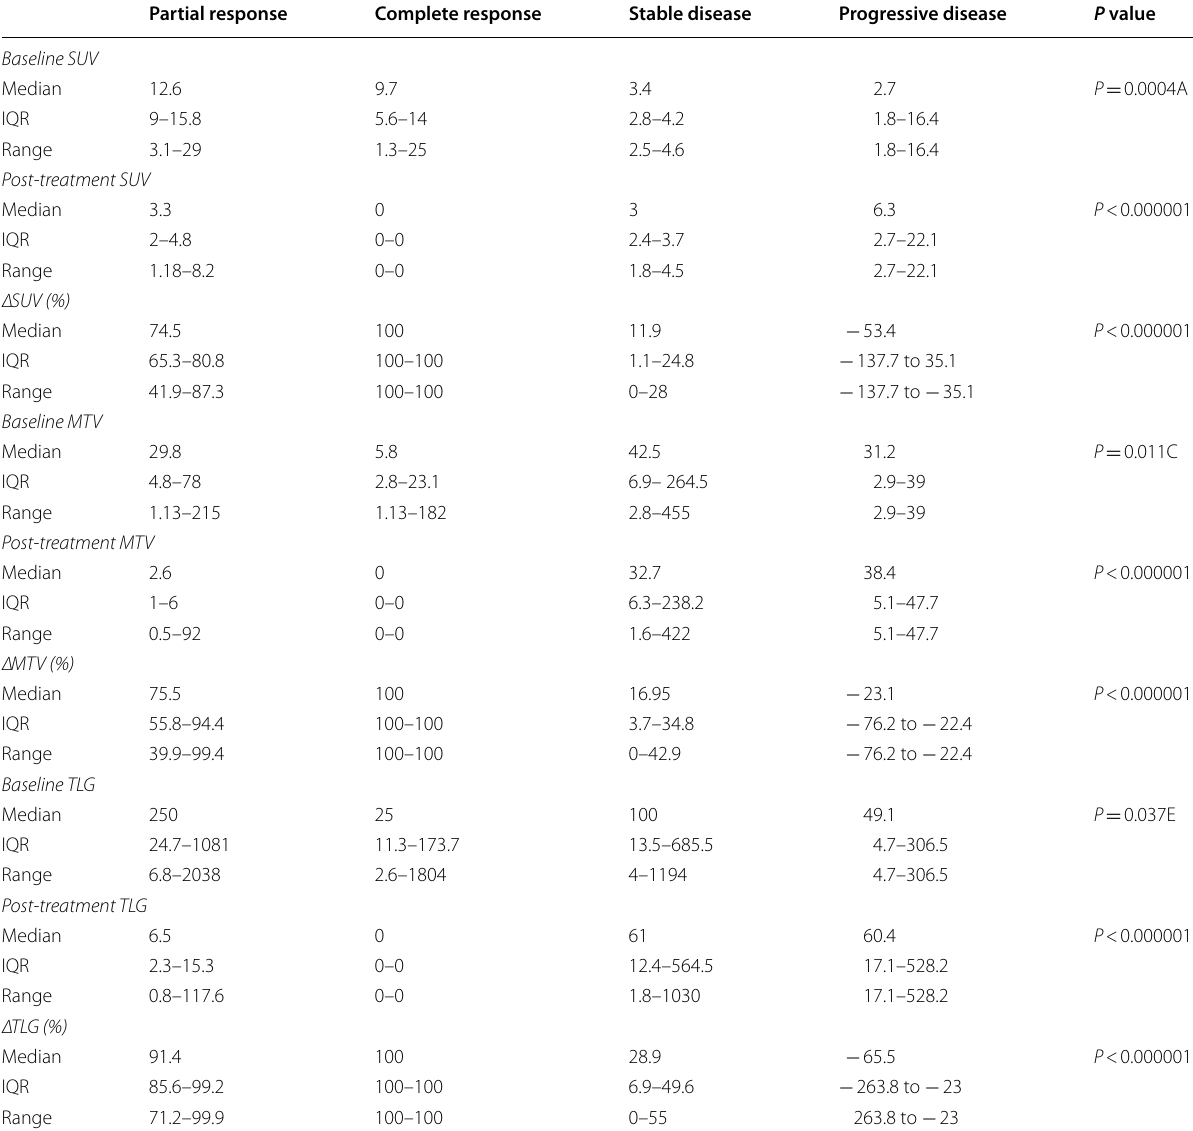
Table 2 Comparison of quantitative PET/CT parameters between all groups Partial